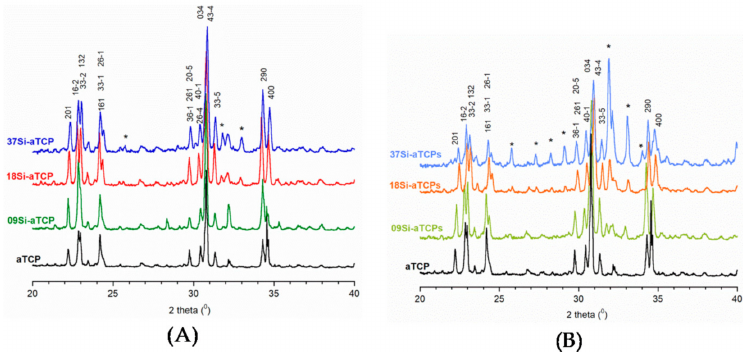
Figure 2. Powder X-ray di ff ractometry (PXRD) di ff ractograms of the x-aTCP ( A ) and x-aTCPs ( B ) samples